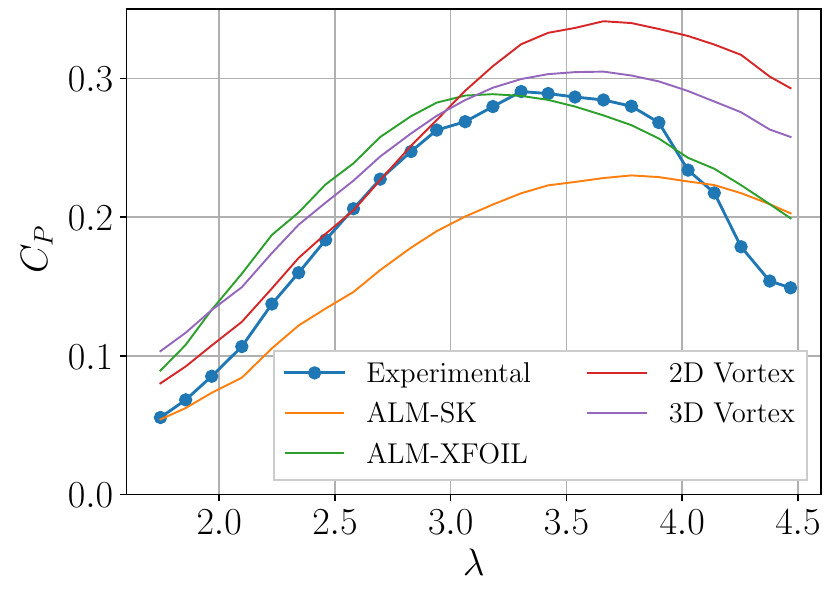
Figure 5. C P as a function of λ . Table 2. Standard deviation of the calculated power coefficient C P as function of λ , for the different employed